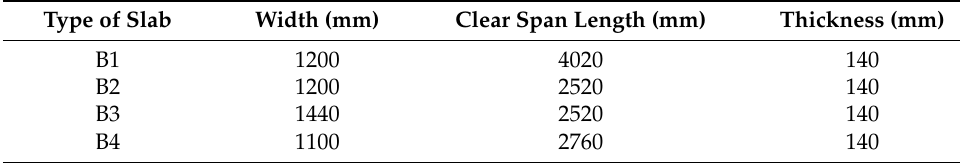
Table 1. Dimensions of composite